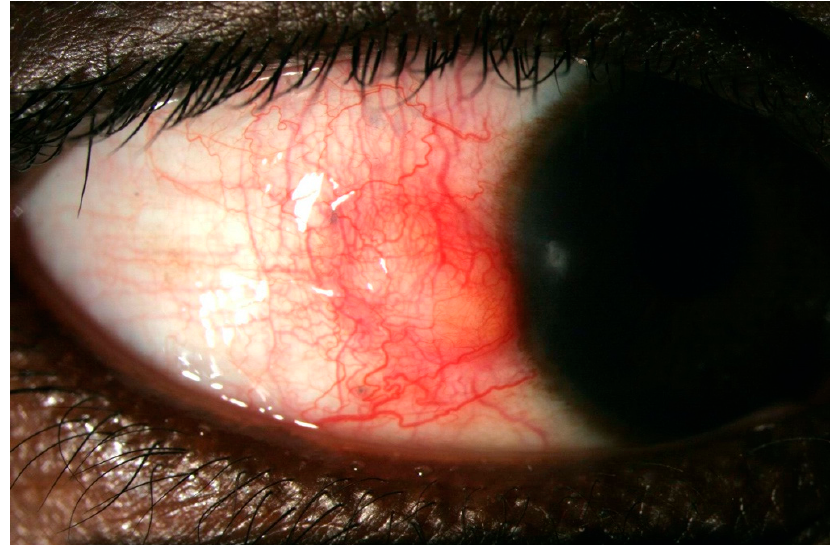
Figure 3. Nodular anterior scleritis. A scleral nodule, totally immobile, lifts the vessels. The nodule is clearly separated from the overlying congested episcleral tissue.